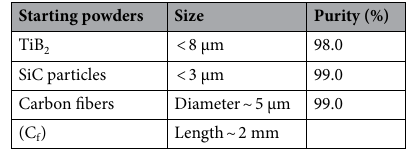
Table 1. Technical information of the as-received